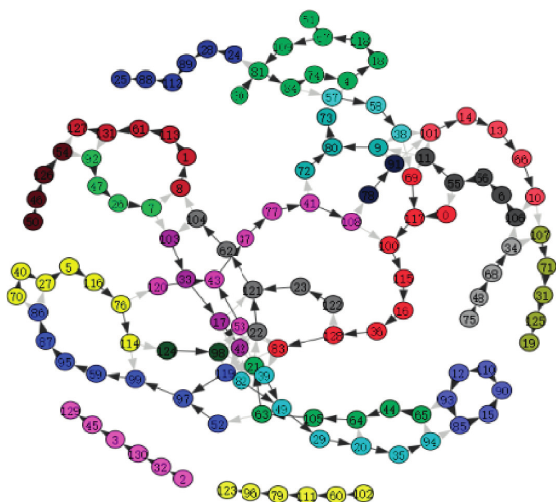
Figure 7: Community structure of the traffic